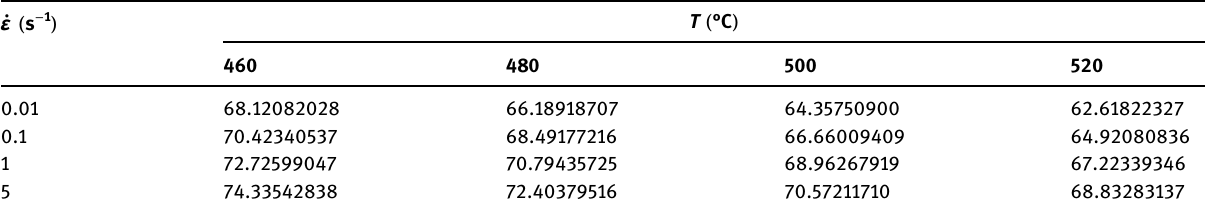
Table 2: The values of Z ln under di ff erent deformation conditions ε ̇ ( s − 1 ) T ( °C )